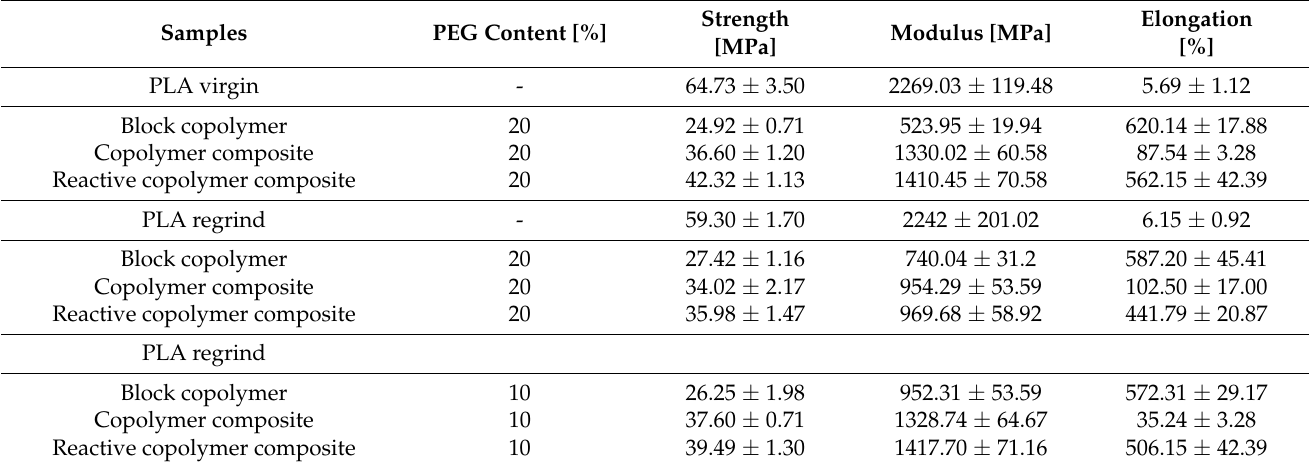
Figure 2. Stress-strain curves of PLA, PLA-PEG (80–20) block copolymer, block copolymer composite (from Method A), and reactive copolymer composite (from Method B). Table 3. Tensile properties of a range of PLA-PEG block copolymers, copolymer composites, and reactive copolymer